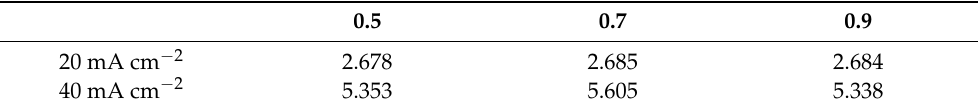
( b ) Figure 14. Coulomb e ffi ciency of ba tt ery with ( a ) di ff erent electrolyte fl ow rates and electrode thick- nesses and ( b ) di ff erent electrolyte fl ow rates and electrode porosities at a current density of 40 mA cm (cid:2879)(cid:2870) . As shown in Figure 15, energy e ffi ciency was also examined with di ff erent combina- tions of fl ow rates, electrode thicknesses, and porosities. As shown in Figure 15a, at 20 mA cm (cid:2879)(cid:2870) , the energy e ffi ciency increases with the fl ow rate at di ff erent electrode thick- nesses, but the e ff ect of di ff erent electrode thickness is complex. For fl ow rate from 20 to